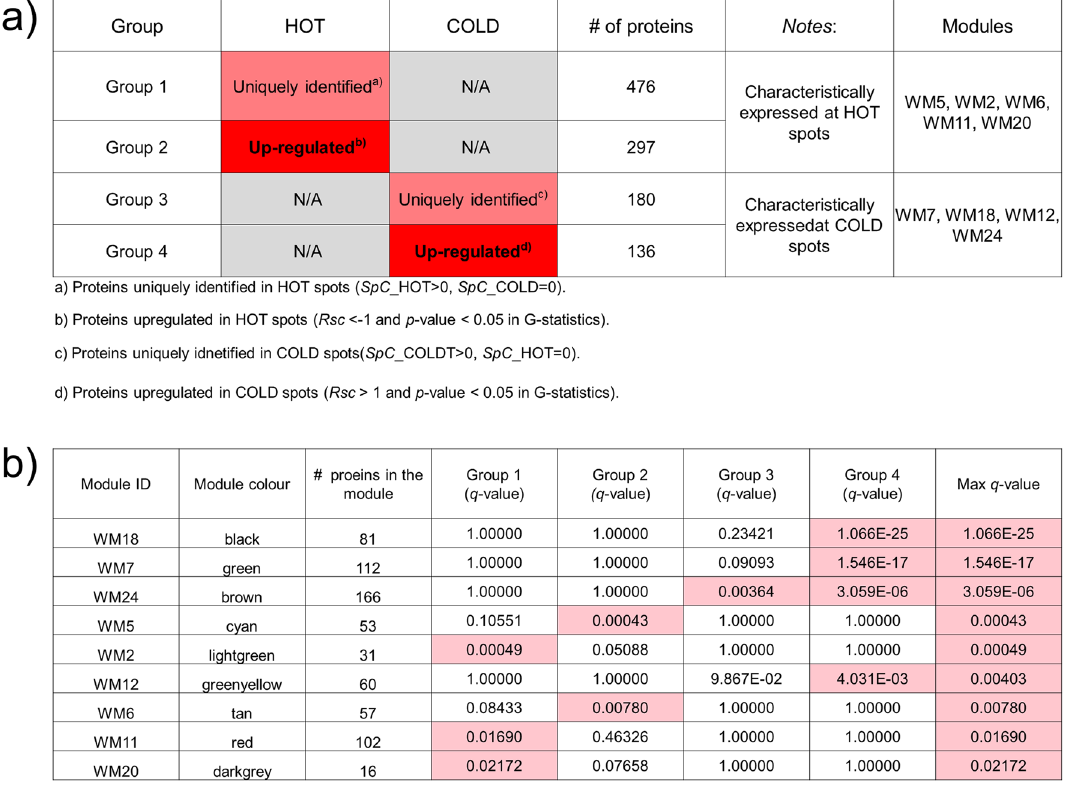
Figure 2. Overlapping proteins unique to the clinical traits and/or upregulated under the HOT or COLD traits, and those from the weighted gene co-expression network analysis (WGCNA). ( a ) Results of identified proteins and spectral counting-based semi-quantitative comparison. Each row represents results for each protein group. The red and pink cells in the HOT and COLD columns indicate that the proteins in the group are uniquely expressed and significantly upregulated, respectively (upregulated with | Rsc |> 1 (HOT > COLD or HOT < COLD). The fourth column shows the number of proteins in each protein group. The fifth column provides notes for each protein group. The WGCNA modules with significant overlap with each protein group are listed in the sixth column (‘Modules’ column). ( b ) Overlap in proteins between the groups according to the protein expression profiles and the modules by WGCNA. Each row in the embedded table represents the overlap analysis results for each module. The first and second columns in the table represent module ID and color name of the module, respectively. The third column represents the number of proteins in each module. The fourth, fifth, sixth, and seventh columns indicate the q values for overlap in proteins between a module by WGCNA and the four protein groups. In the five columns, significant q -values are highlighted in red. The eighth column represents the value of the most significant q -value (max q -value) in each module. The nine modules with max q -values < 0.05 are listed in